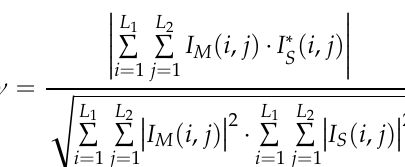
Figure 9. ( a ) PS coherence map calculated with the interferogram IM coherence lower than